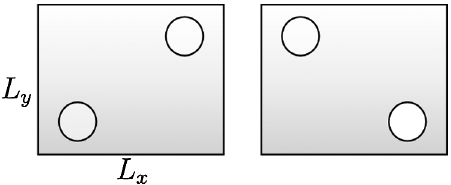
FIG. 5. The two possible configurations of two quasiholes, which are distinguished by the value of (cid:10) ¼ sgn ð h (cid:1) h Þ . Left: (cid:10) ¼ þ . Right: (cid:10) ¼ (cid:1) sgn ð h 1 y 2 y